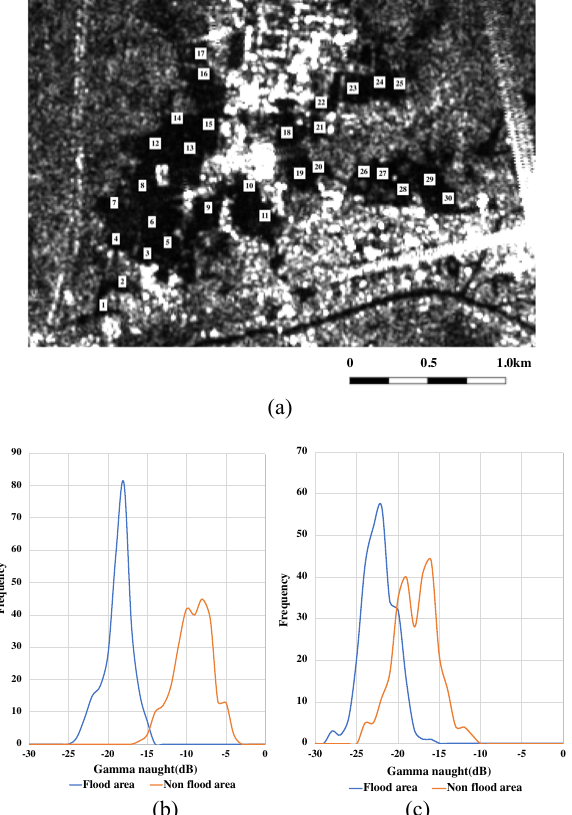
Figure 4. Gamma-naught distributions for both flood and non- flood rice paddy fields. (a) 30 sampling points in Tegalluar area, (b) VV gamma-naught and (c) VH gamma-naught distributions in both flood and non-flood rice paddy fields.